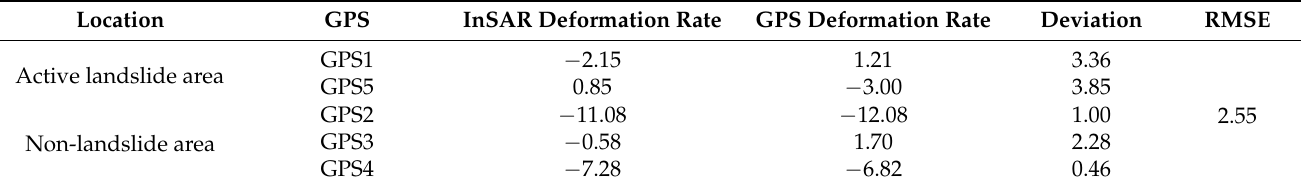
Table 3. Comparison between Time-Series InSAR measurements and GPS observations (mm/yr). Location GPS InSAR Deformation Rate GPS Deformation Rate Deviation RMSE GPS1 − 2.15 Active landslide area Non-landslide area